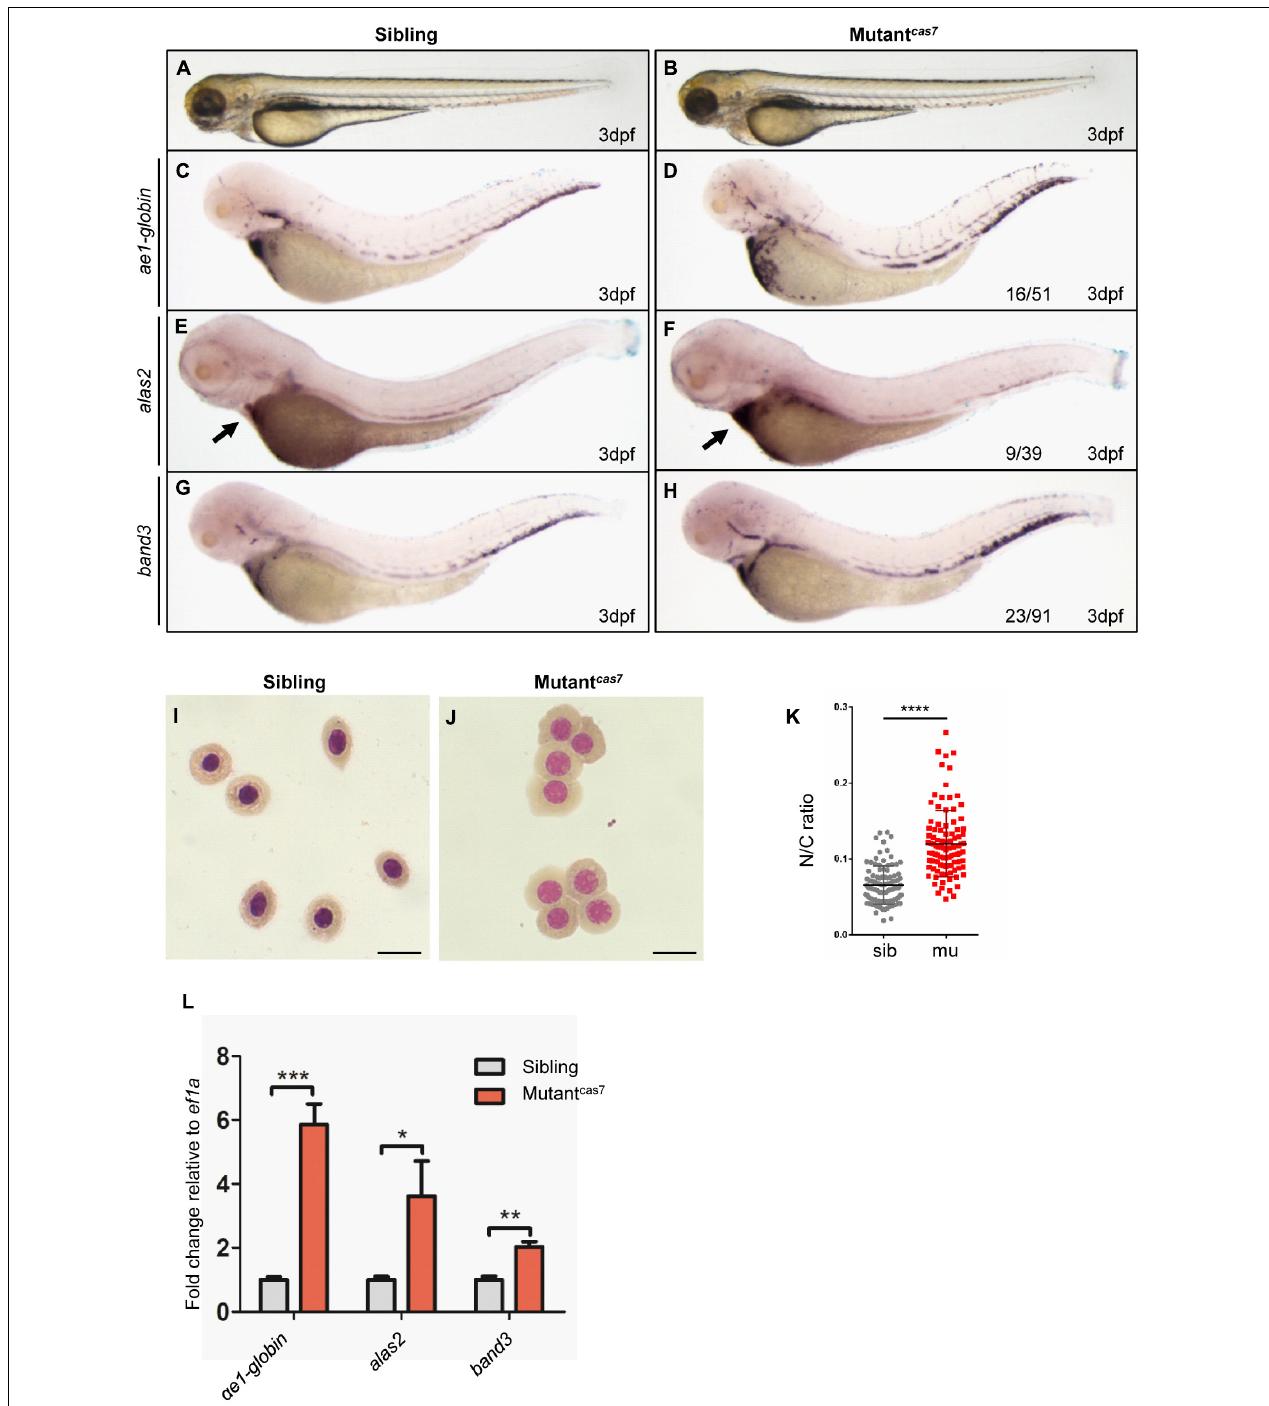
FIGURE 1 | Erythroid maturation is disrupted in zebrafish mutant cas 7 . (A,B) Light microscope images of zebrafish wild-type (WT) sibling and mutant cas 7 embryos at 3 dpf. (C–H) WISH analysis of ae1-globin (C,D) , alas2 (E,F) , and band3 (G,H) expression in sibling and mutant cas 7 embryos at 3 dpf. After WISH and photographing, all embryos were extracted for genomic DNA and genotyped by sequencing, then the mutant percentage was evaluated. The number of embryos in a het-het incross clutch with the expression pattern is shown in the mutant cas 7 column and corresponding percentages are listed inside each panel. Arrow in panel (E,F) indicates the alas2 staining in heart region. (I,J) Giemsa staining for erythrocytes at 4 dpf in sibling and mutant cas 7 . Relative to the number of orthochromatophilic erythroblasts, mutant cas 7 displayed a marked increase in circulating polychromatophilic erythroblasts compared with sibling. Scale bars represent 10 µ m. (K) Statistical analysis of the nucleus-to-cytoplasm (N/C) ratio in sibling and mutant cas 7 . N = 100, error bars represent SEM. **** p ≤ 0.0001. (L) The relative expression of α e1-globin , alas2 , band3 in sibling and mutant cas 7 embryos at 3 dpf. Error bars represent SEM. * p ≤ 0.05; ** p ≤ 0.01; *** p ≤ 0.001.